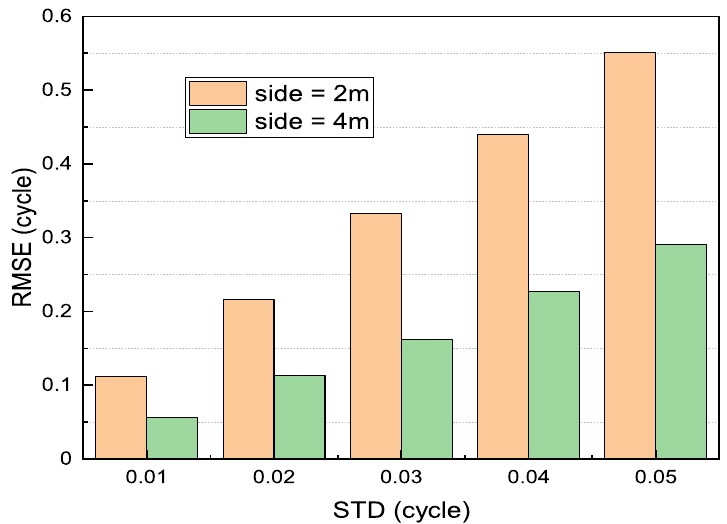
Figure 7. RMSE values of AR for squares with different trajectory sizes.